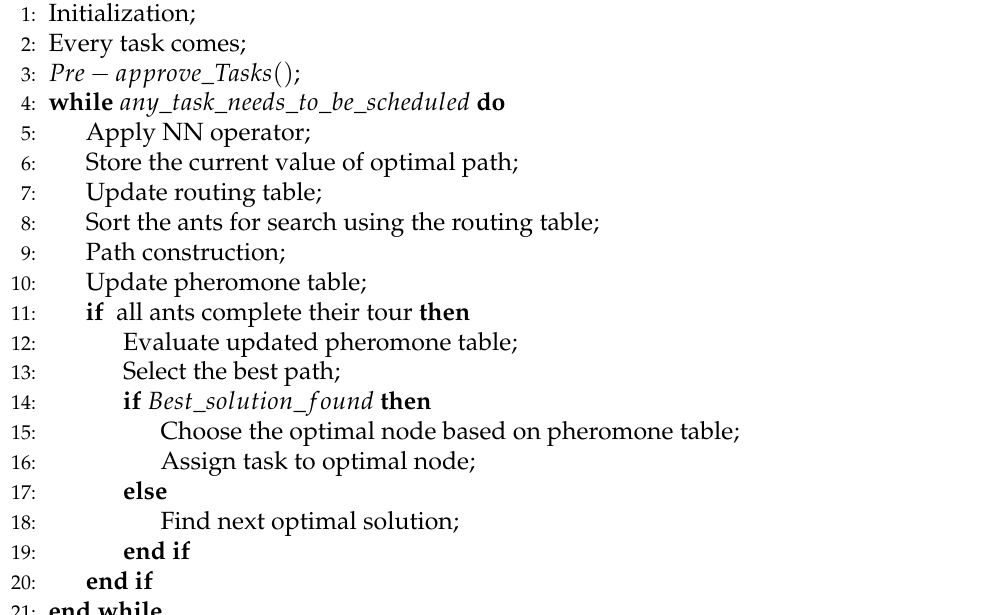
Algorithm 1 Pseudocode of nearest-neighbor ant colony